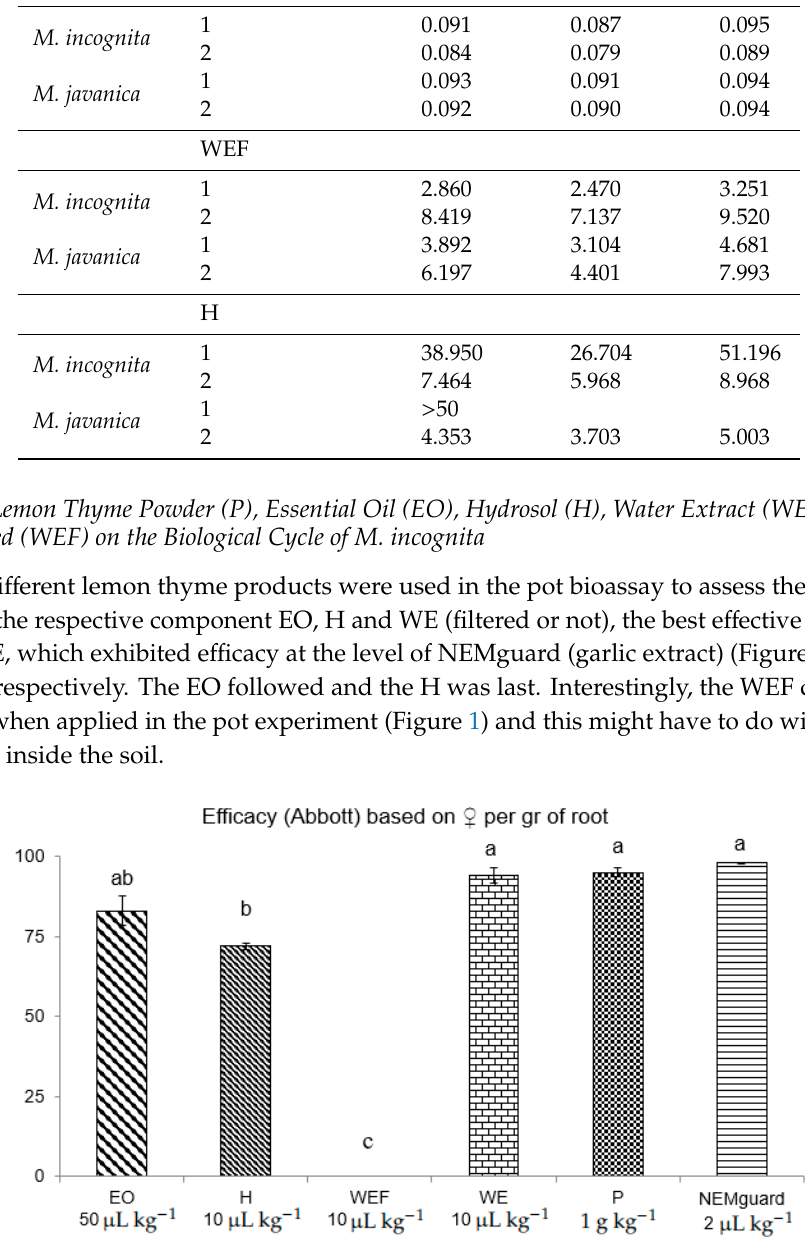
Figure 1. Nematicidal activity ( ± st. error) of di ff erent lemon thyme botanical products (EO: essential oil; H: hydrosol; WEF: water extract filtered; WE: water extract; P: powder and NEMguard) against Meloidogyne incognita based on female counts per gr of root, 45 days after treatment. Di ff erent letters above columns correspond to statistically significant di ff erences between